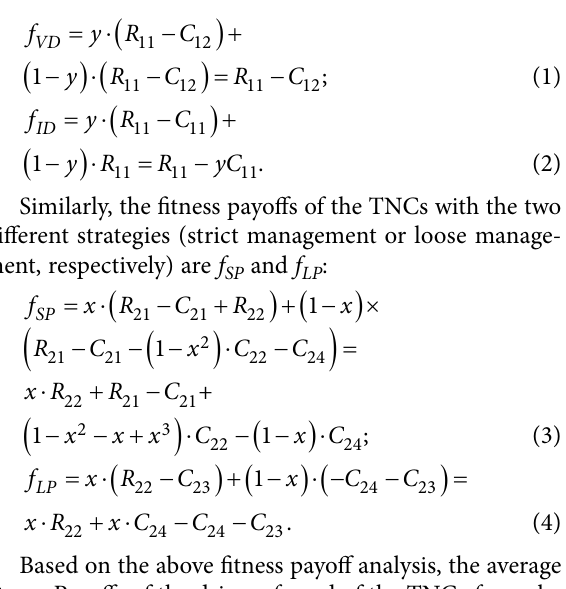
Table 1. Payoff matrix of the TNCs and drivers under the control of government regulators Drivers Strict management Loose management Legal